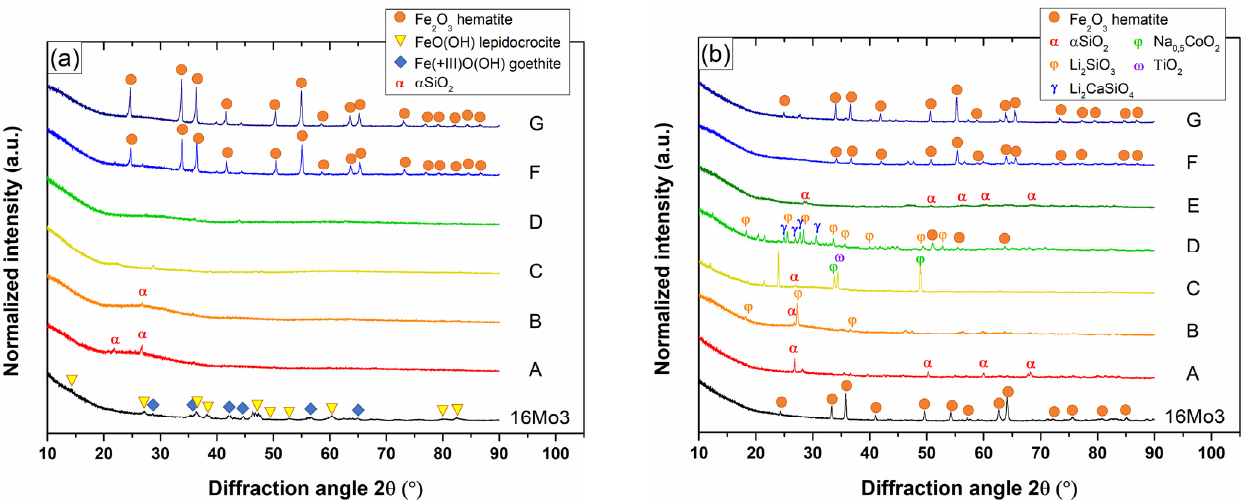
Figure 3. XRD diffraction plots for ( a ) the initial samples and ( b ) the oxidized samples at 650 °C for 48 h in Ar-10%H 2 O atmosphere.